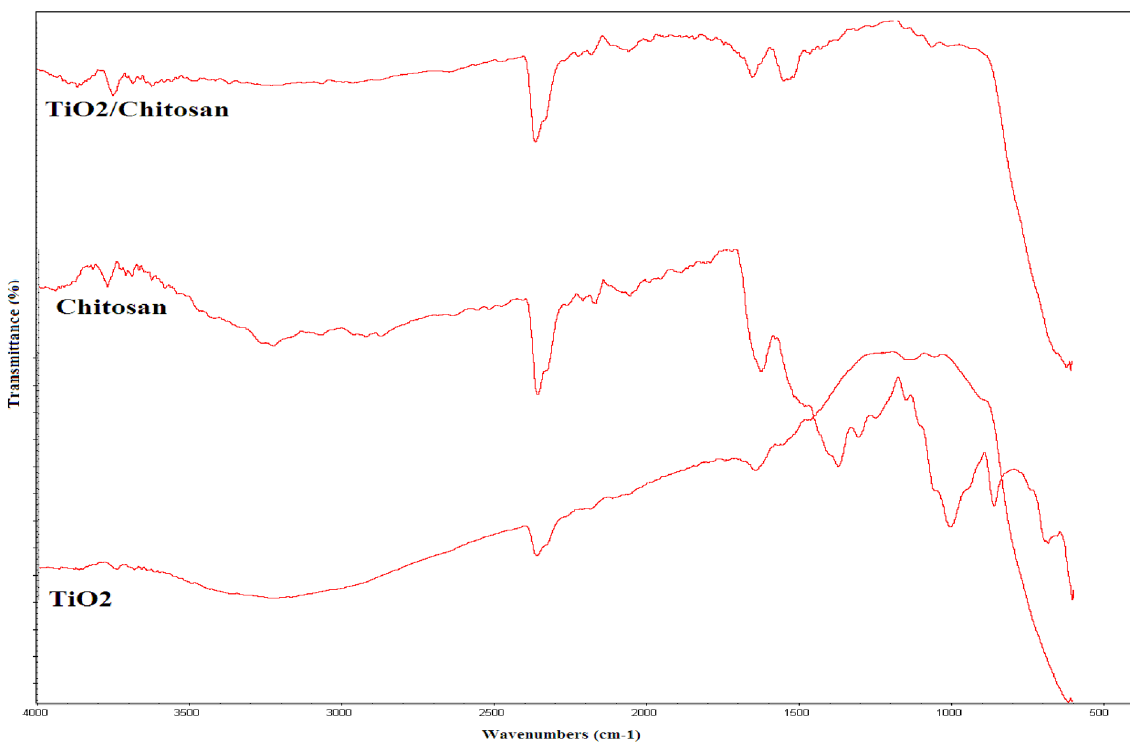
Figure 3. FTIR spectra of chitosan, TiO 2 and TiO 2 –chitosan